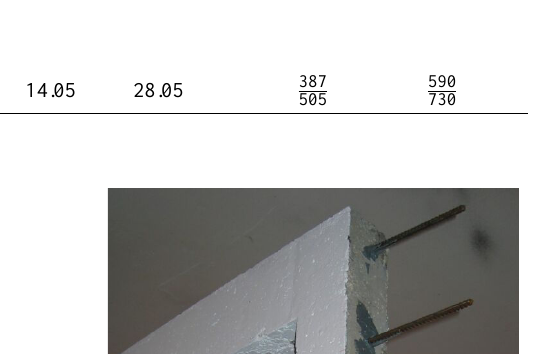
Figure 1. Dimensions and reinforcement layouts of RC frame and external shear wall for the 1 st group tests (Arslan, 2007 - Kaltakci, 2007)